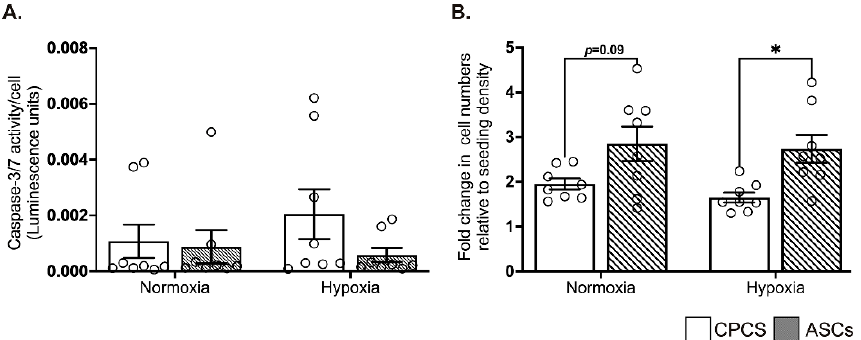
Figure 3. Effect of hypoxia on CPCs’ and ASCs’ quantitative scatter plot column graphs showing caspase-3/7 activity ( A ) and cell proliferation ( B ) in CPCs and ASCs cultured under normoxia and hypoxia. Caspase-3/7 activity is expressed after normalizing to the cell number ( A ). Cell proliferation is expressed as fold changes in cell numbers relative to the seeding density ( B ). Data are represented as mean ± SEM (n = 8 in each group); * p < 0.05. All the experiments were performed in triplicates and repeated at least 2 independent times.